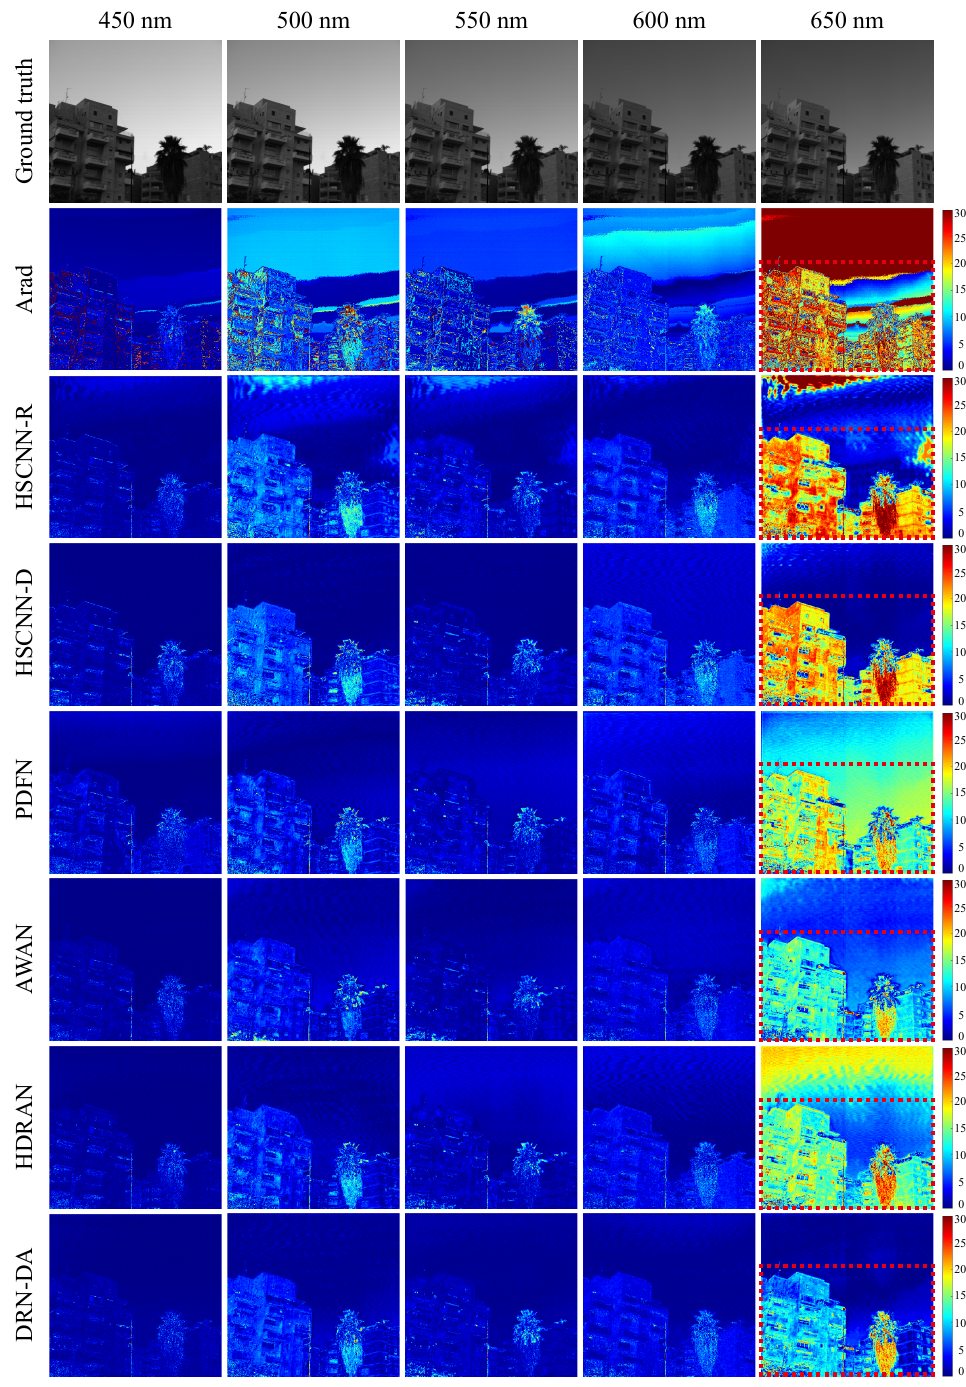
Figure 8. Visual hyperspectral reconstruction results and visual comparisons of five selected bands for hyperspectral reconstruction error maps from one NTIRE 2020 “Clean” RGB image. The significant differences are shown in the red frames. Please zoom in for better